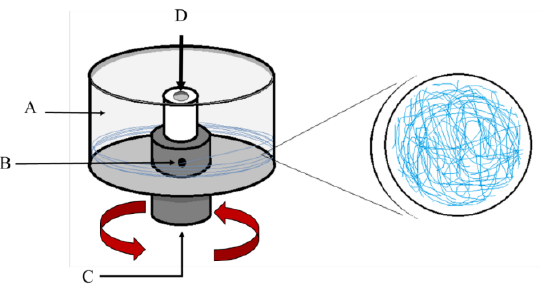
Figure 3. RJS apparatus: (A) collector, (B) reservoir, (C) motor, (D) feeding zone (modified with permission from [69], Copyright 2015 American Chemical Society).